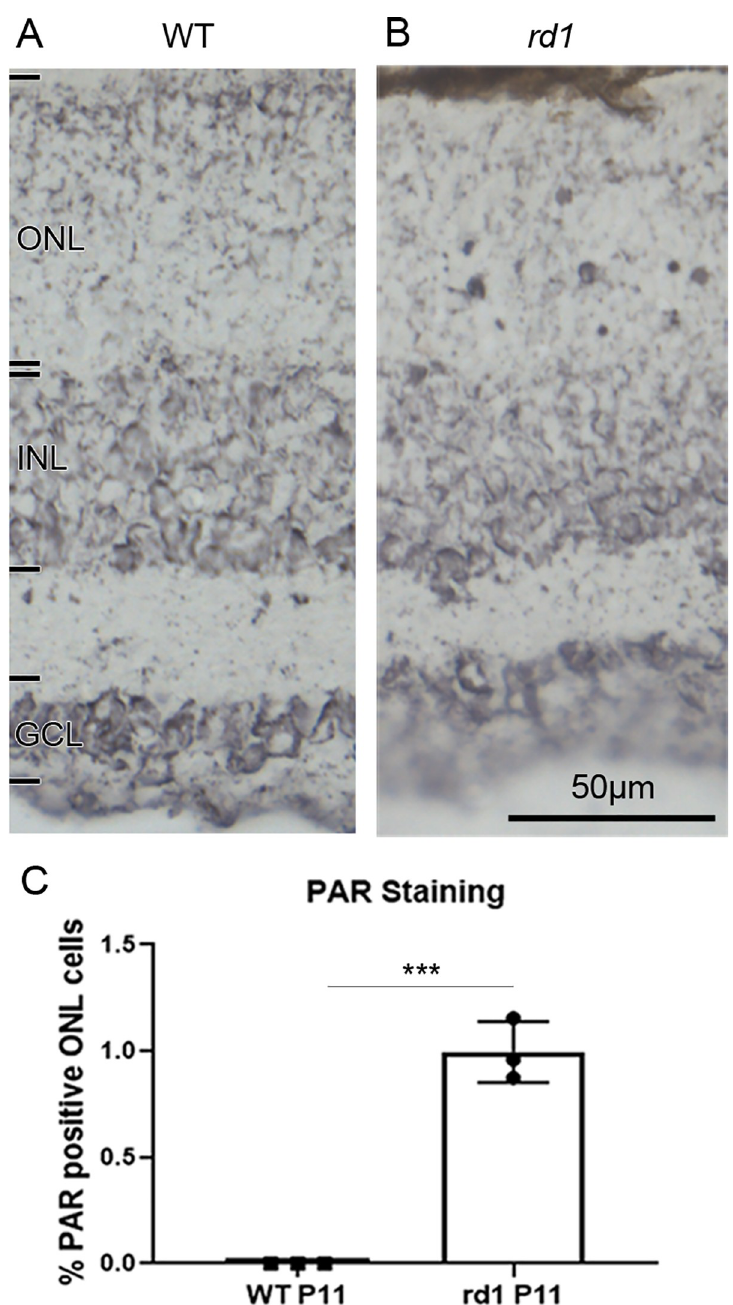
Fig 3. Immunostaining for poly-ADP-ribosylation in wild-type and rd1 retina. To indirectly assess PARP activity an immunostaining for poly-ADP-ribosylation (PAR) was employed. While post-natal (P) day 11 wild-type (WT) outer nuclear layer (ONL) is essentially devoid of nuclear PAR staining ( A ), in the rd1 situation ( B ) numerous photoreceptor nuclei show a marked PAR label. ( C ) Quantification of PAR positive nuclei in the ONL, with n = 3. error bars indicate STD; statistical analysis: Student´s t-test. INL = inner nuclear layer, GCL = ganglion cell layer. Images representative for PAR immunostaining performed on tissue sections derived from at least three different WT and rd1